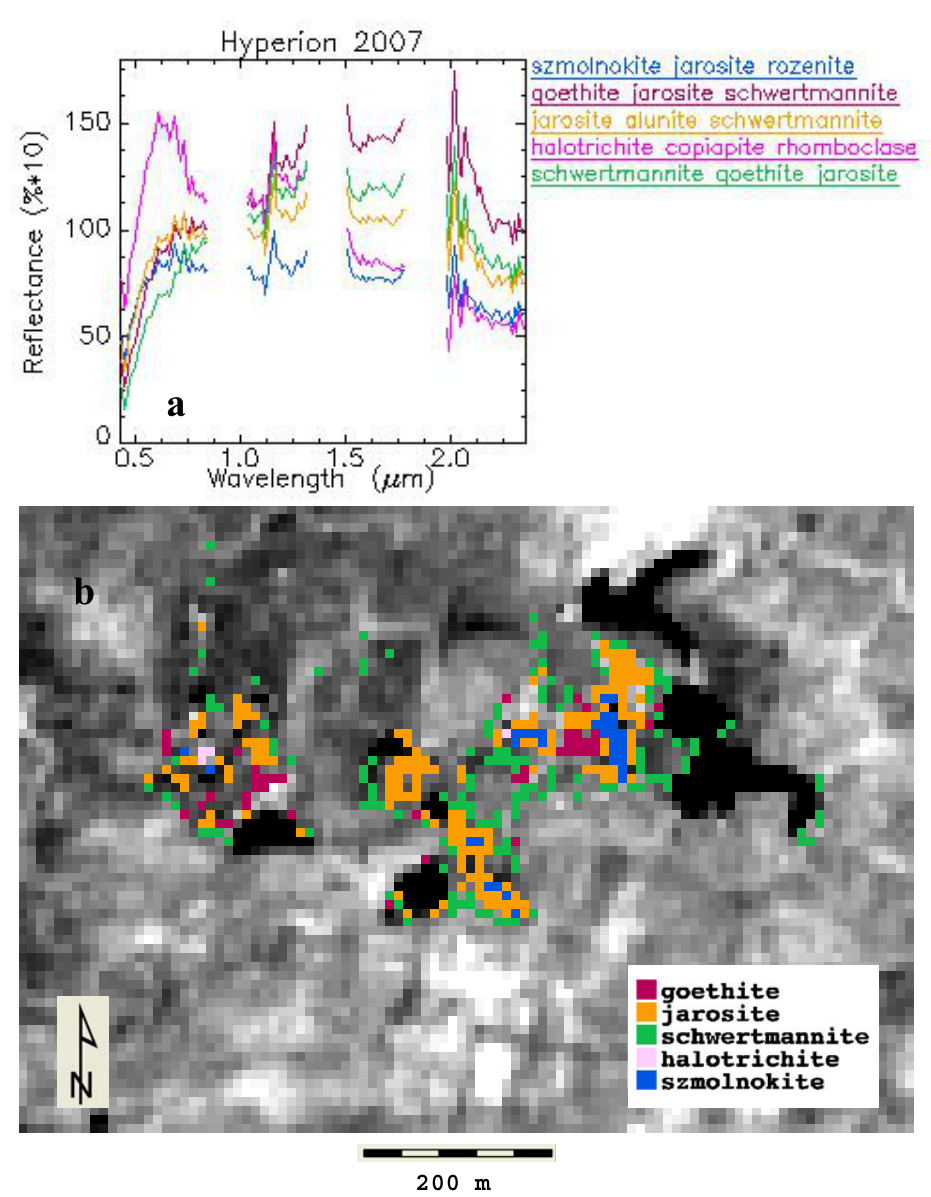
Figure 9. (a) Spectra from Hyperion data corrected with ATCOR4 on the Las Herrerias mine site, collected on 24 August 2007, using one light and one dark calibration target and the flat terrain mode. The legend follows the trends shown on the map built from Hymap 2009 data (Figure 5). (b) Map built from Hyperion 2007 data corrected with ATCOR4 (one light and one dark target) with geological units diagnosed mineralogically with the Spectral Analyst (RSI, [35]) and the reference spectral library on pyrite weathering products (Crowley et al. , [10]), taking into account variable results from every diagnosing algorithm (Riaza et al .,